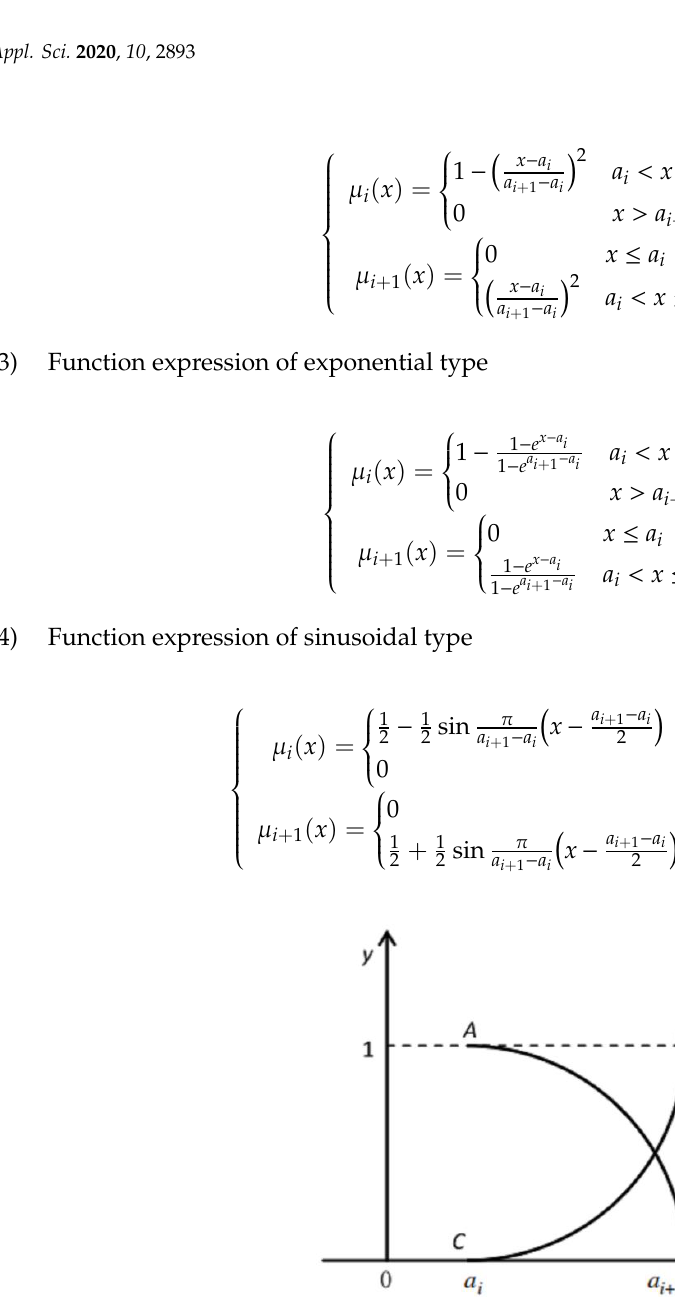
Figure 1. Linear-type function.